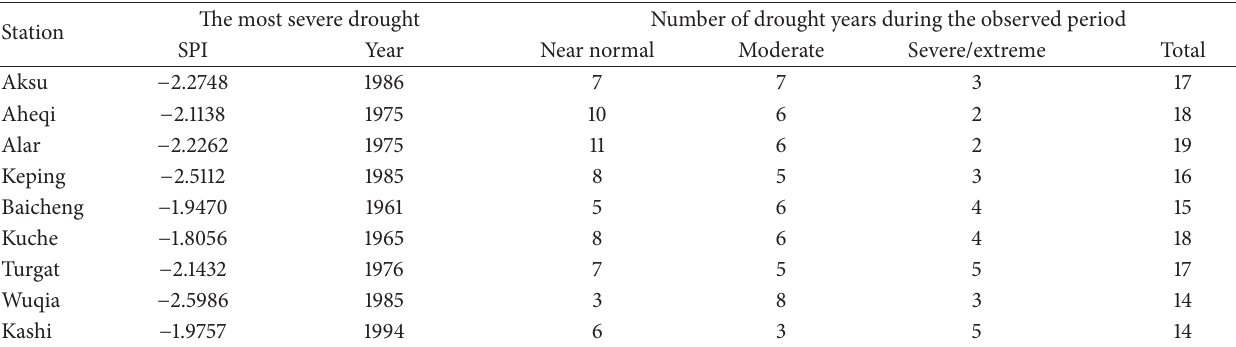
Table 8: Characteristics of droughts at 12-month time